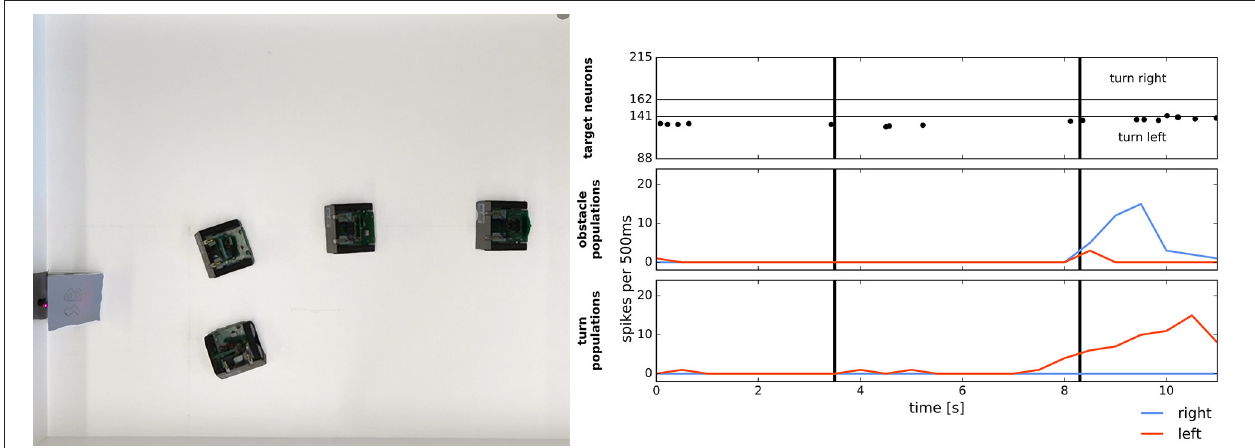
FIGURE 14 | Simple target acquisition: single stationary target. Left: Overlay of video frames from the overhead camera. The robot approaches a stationary target on the left-hand side of the arena from right to left. The robot turns left toward the target until it perceives it as an obstacle and makes an obstacle avoidance maneuver. Right: Time-course of the spiking activity (raster plot) of the target-representing (WTA) neurons on the ROLLS chip (top plot) and summed (over 500 ms and over populations) activity of neurons in obstacle representing and drive populations on the ROLLS chip. Vertical lines mark time points that correspond to two middle positions of the navigating